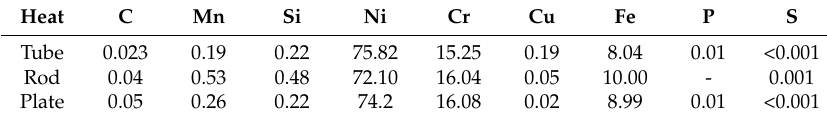
Table 1. Chemical composition of Alloy 600 heats used in the study (in wt%).